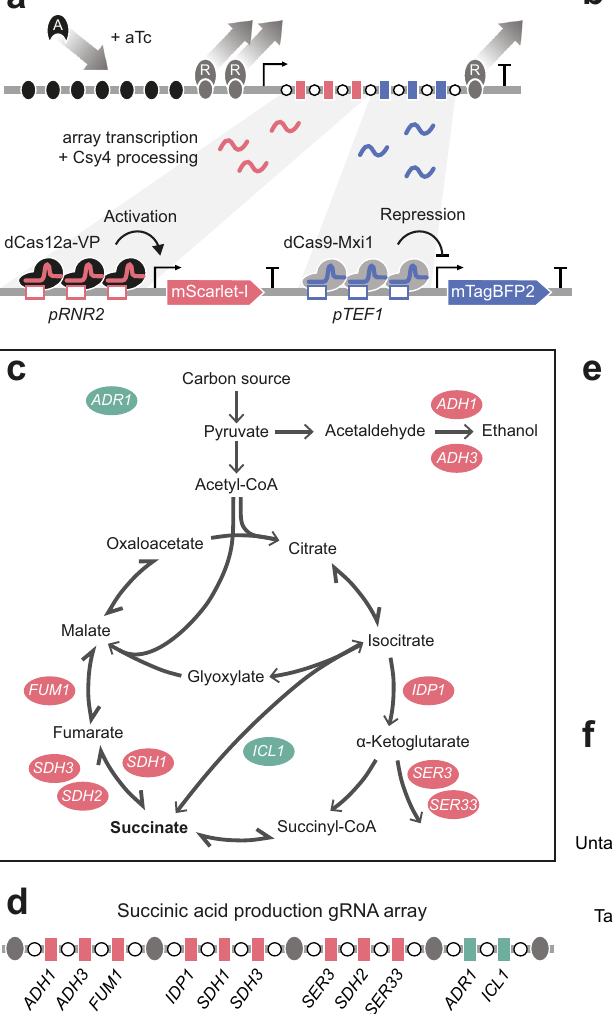
Fig. 3 | Inducible CRISPRai for metabolic engineering. a Inducible CRISPRai gRNA array containing three activation gRNAs targeting the RNR2 promoter (red) followedbythreerepressiongRNAstargetingthe TEF1 promoter(blue).Expression and Csy4 processing of the gRNA array results in the upregulation of mScarlet-I, throughtherecruitmentofdCas12a-VPtothe RNR2 promoter,anddownregulation of mTagBFP2 through recruitment of dCas9-Mxi1 to the TEF1 promoter. b